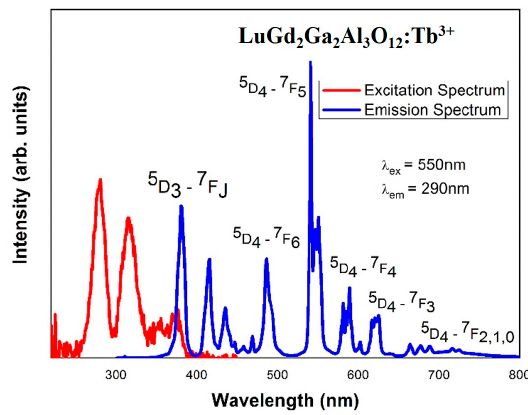
Figure 5. UV induced emission peaks of LuGd 2 Ga 2 Al 3 O 12 :Tb 3 + phosphor.